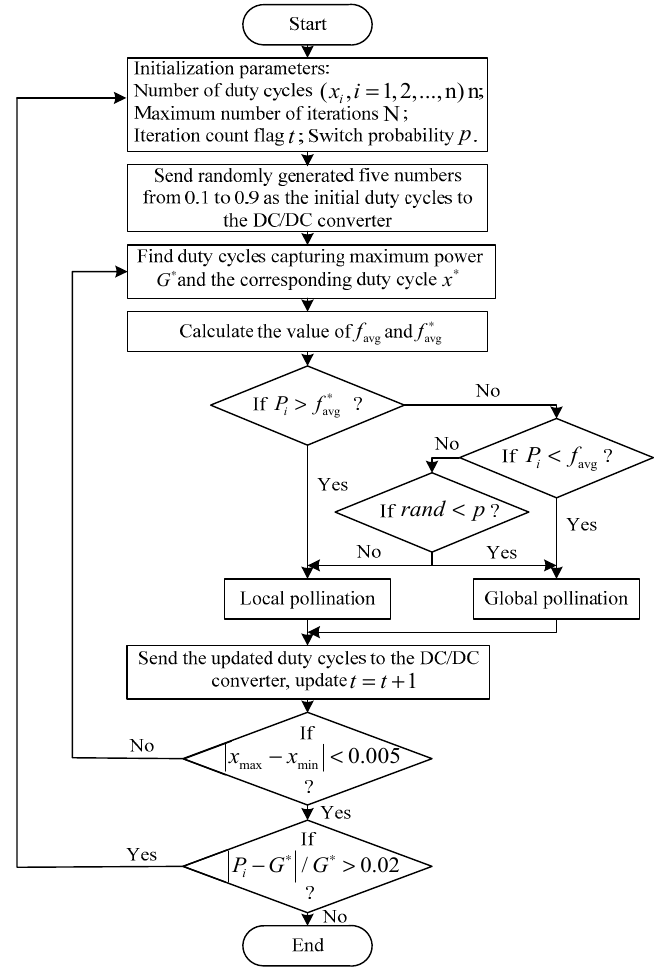
Figure 4. Flowchart of MPPT based on MPFA.